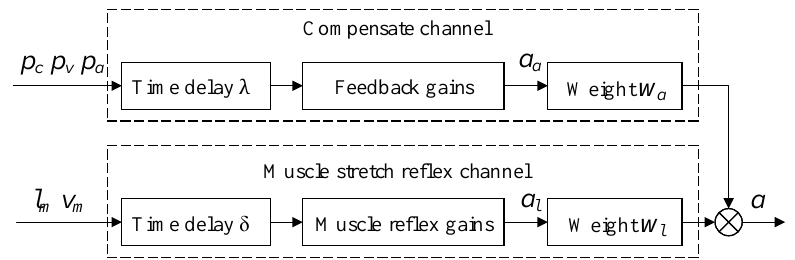
Figure 5. The framework of virtual muscle activation